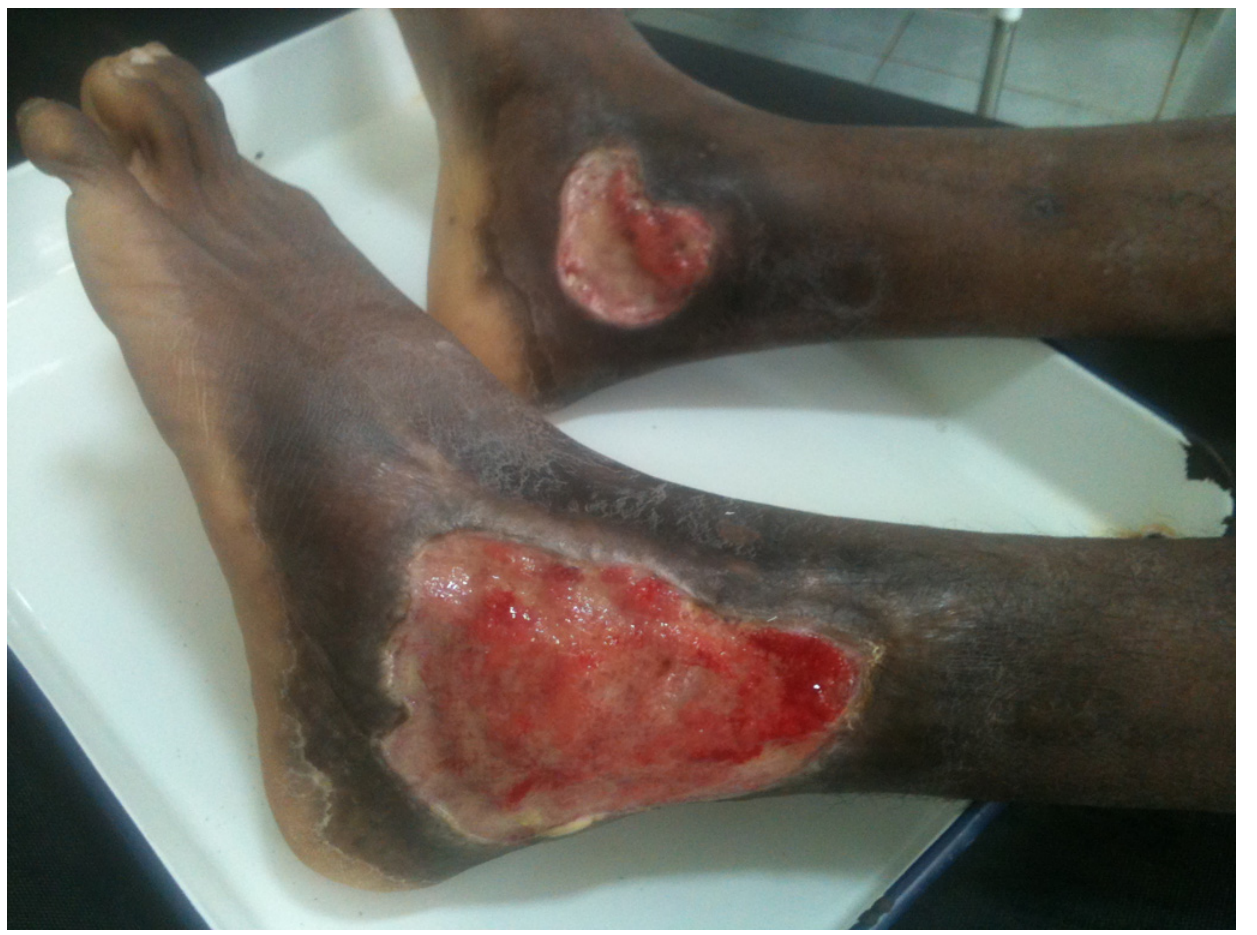
Fig 2. Image illustrating the severity of lesions in Buruli ulcer-HIV coinfected individuals; extensive bilateral ankle ulcers.